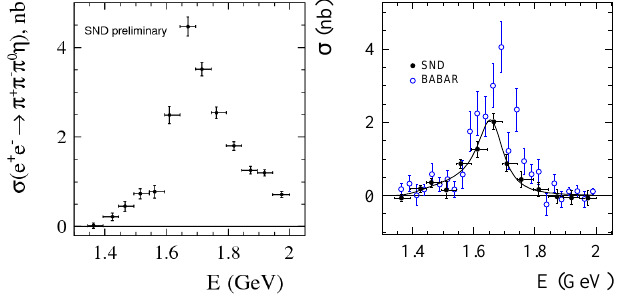
Figure 5. Left panel : The e + e − → π + π − π 0 η cross section measured by SND. Right panel : The e + e − → ωη cross section measured by SND in comparison with BABAR data [22]. The curve is the result of the VMD fit.